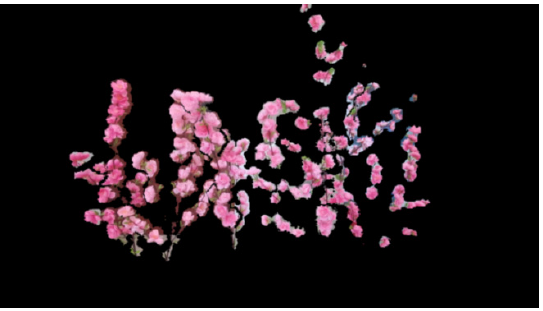
Figure 2. Image after segmentation based on depth